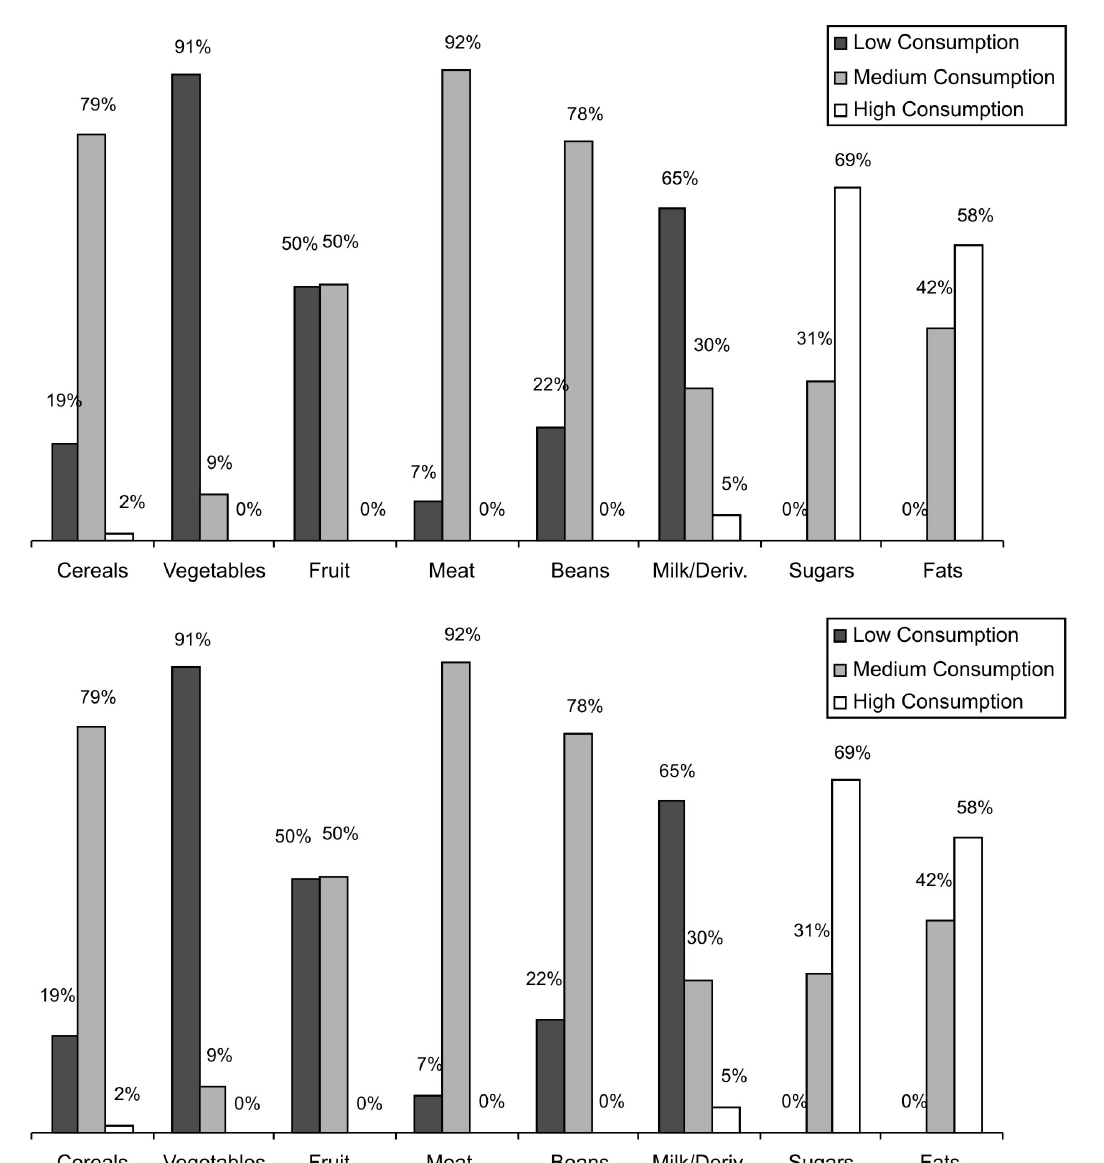
FIGURE 1 - Distribution of percentage of children according to consumption of food groups. Maringá – PR,